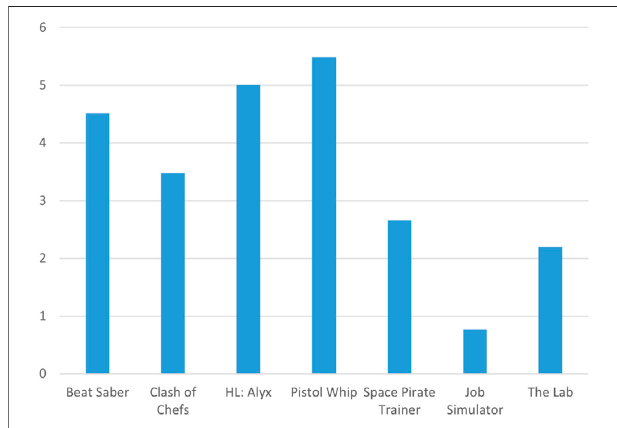
FIGURE 1 | Summary of data collected by game.